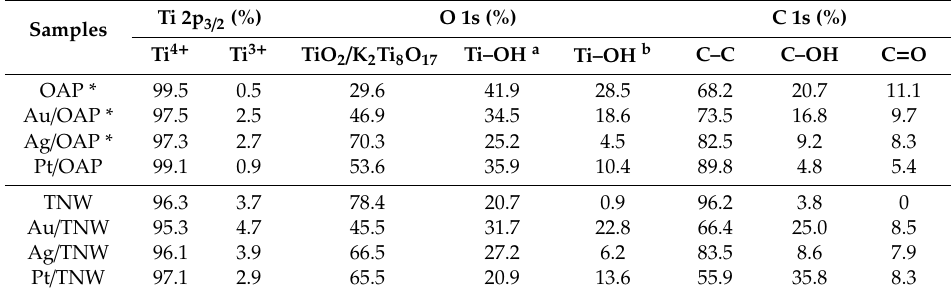
Table 3. Fraction of oxidation states of Ti, O and C from deconvolution of XPS peaks of Ti 2p3 / 2, O 1s and C